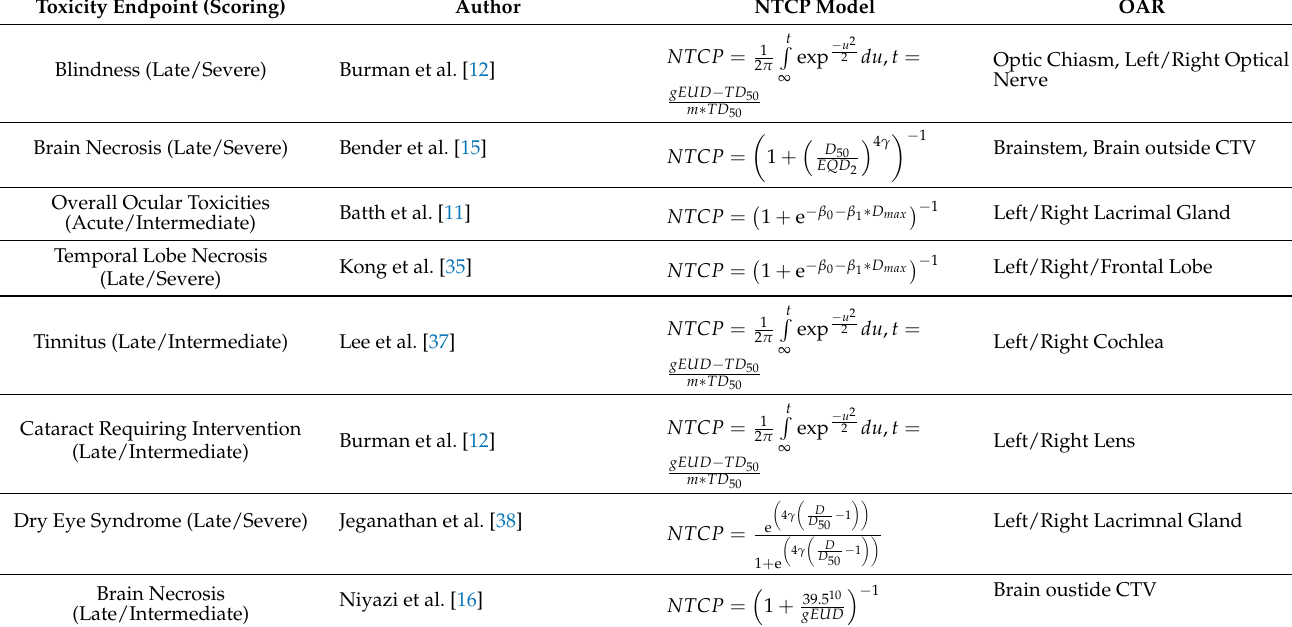
Table 2. Details of the selected NTCP models for the listed